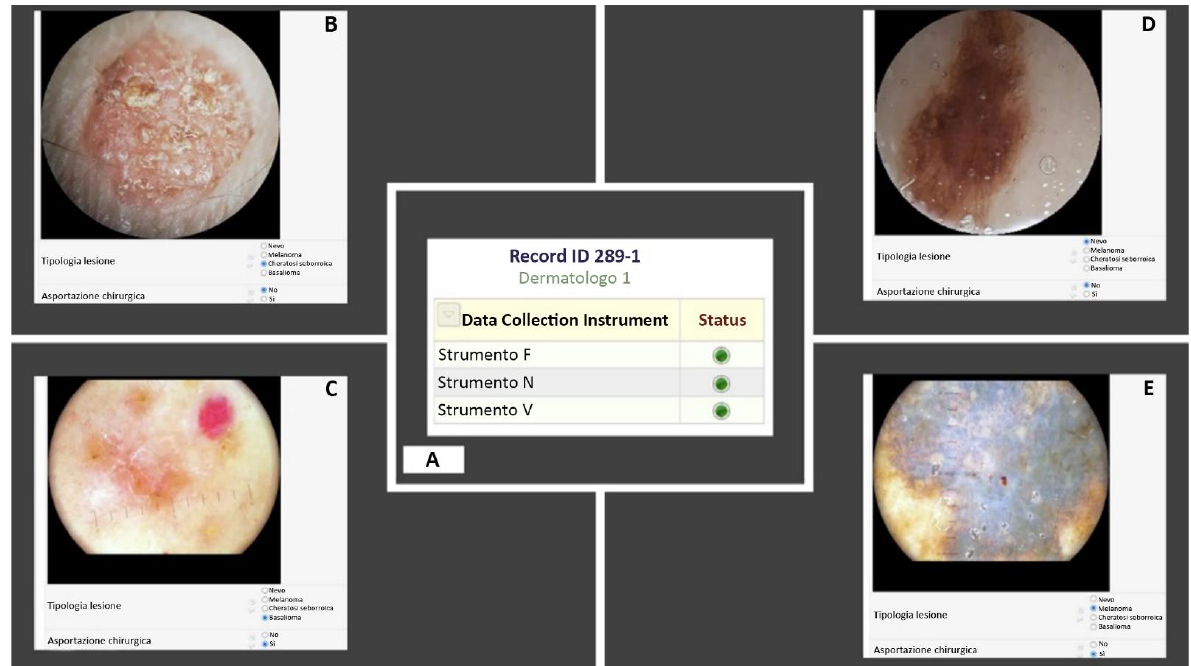
Figure 2. Examples of images to be evaluated through the REDCap software; ( A ) Table of the in- struments in use. The images were acquired with instrument N ( B ), F ( C ) and V ( D , E